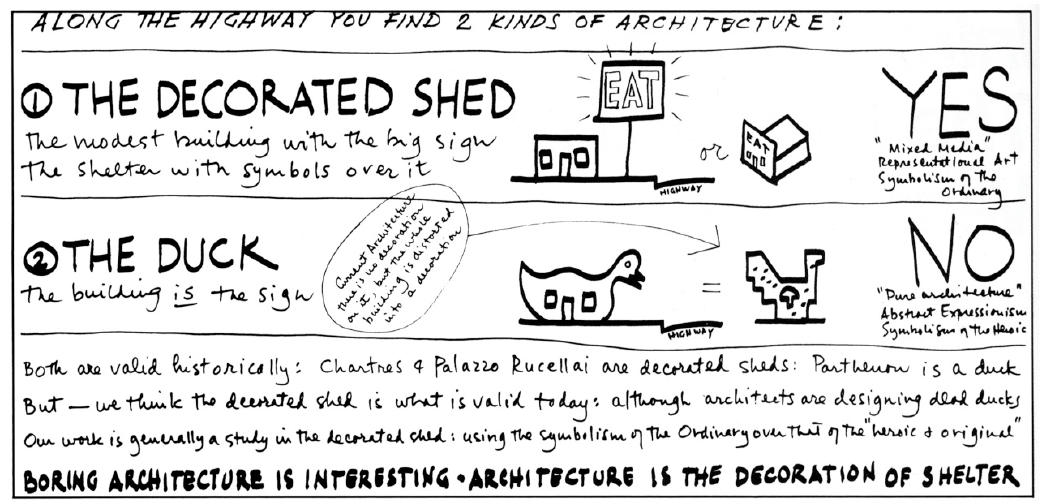
Figure 4. Robert Venturi, Denise Scott Brown, and Steven Izenour, Learning from Las Vegas. First edition, 1972. Credit Line: Venturi, Scott Brown Collection, The Architectural Archives, University of Pennsylvania.